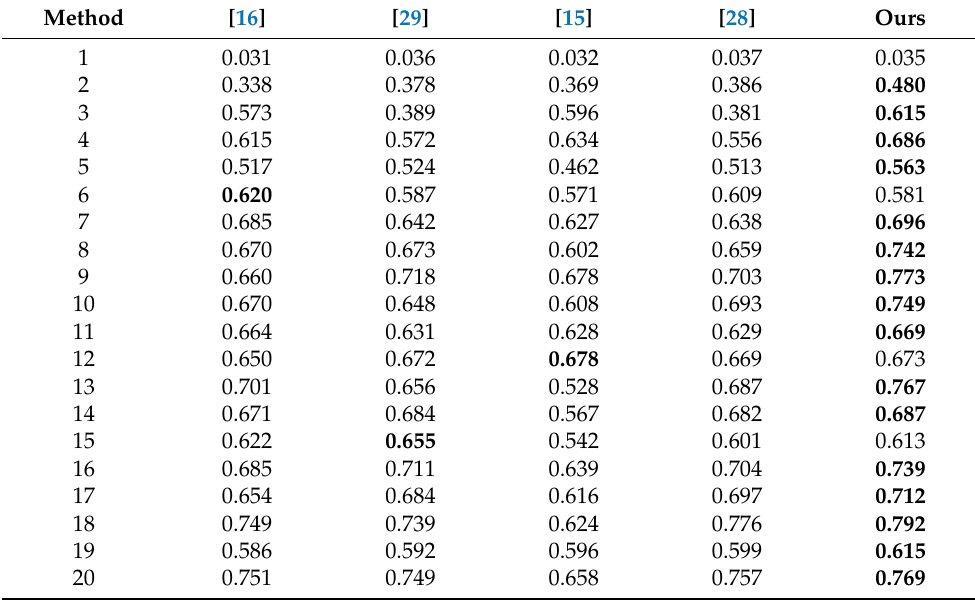
Table 2. Objective evaluation results of Q AB/F.